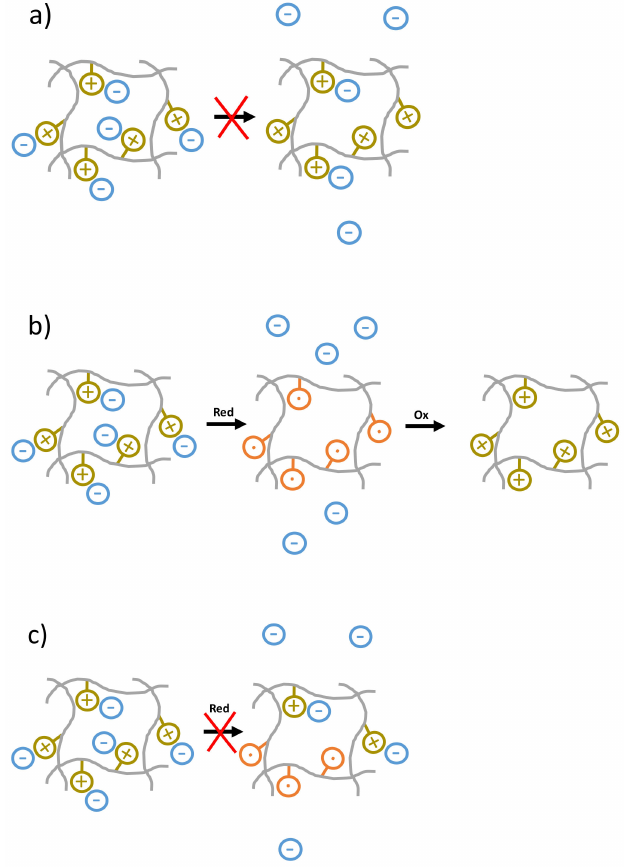
Figure 2. Sketches for encapsulation-release of aspirin from P(TEMPO + - r -OEGMA) hydrogels (grey lines stand for polymer chains, negatively charged aspirin molecules are represented in blue, positively charged oxoammonium are represented in yellow-greenish and nitroxide radicals are in orange). ( a ) Firmly attached aspirin do not diffuse out of the positively charged oxidized hydrogel. ( b ) The whole aspirin molecules are released from the hydrogel upon electrochemical reduction and the re-oxidized hydrogel contains no longer aspirin molecules. ( c ) Incomplete release (e.g., due to incomplete reduction of oxoammonium cations) is not